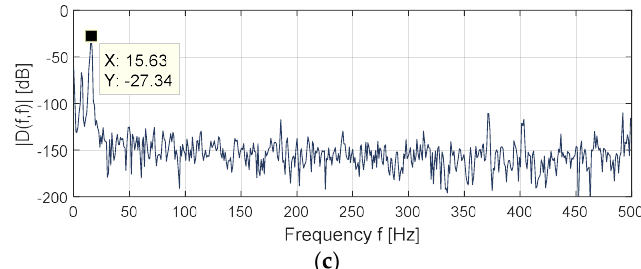
Figure 14. TST PMSG stator current of the healthy rotor blades: ( a ) bispectrum, ( b ) normalized bispectrum amplitude, and ( c ) diagonal slice of the bispectrum (DSB).